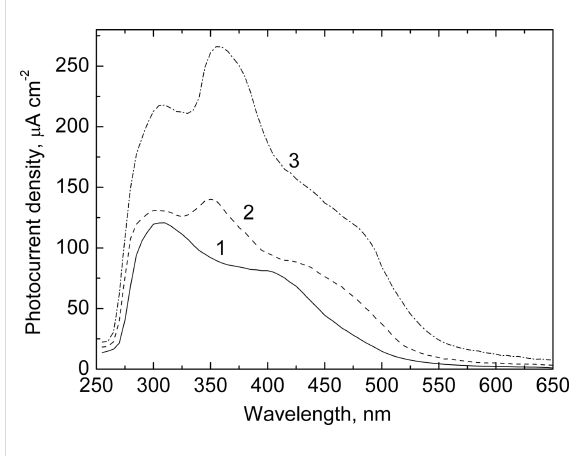
Figure 9: Photocurrent spectra of In 2 O 3 (400)/CdS film electrodes in 0.1 М Na 2 S + 0.1 M Na 2 SO 3 + 0.1 M NaOH solution. The spectra were measured at a potential of − 0.1 V versus Ag/AgCl. The number of the SILAR cycles of CdS deposition was 10 (1), 30 (2) and 50 (3).